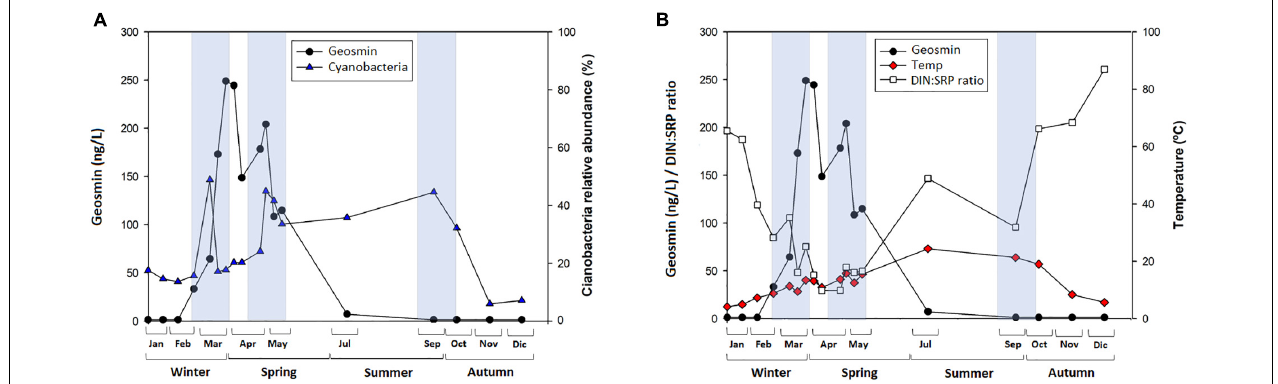
FIGURE 6 | (A) Mean value and standard deviation of geosmin concentration (nanogram per liter), and cyanobacteria relative abundance (%) and (B) mean value and standard deviation of geosmin concentration (nanogram per liter) and DIN:SRP ratio (mol/mol), water temperature ( ◦ C) in T4 sampling site for different sampling in 2019, being Jan = January, Feb = February, Mar = March, Apr = April, May = May, Jul = July, Sep = September, Oct = October, Nov = November, and Dec = December. Blue boxes indicate time when cyanobacteria relative abundance in biofilm was